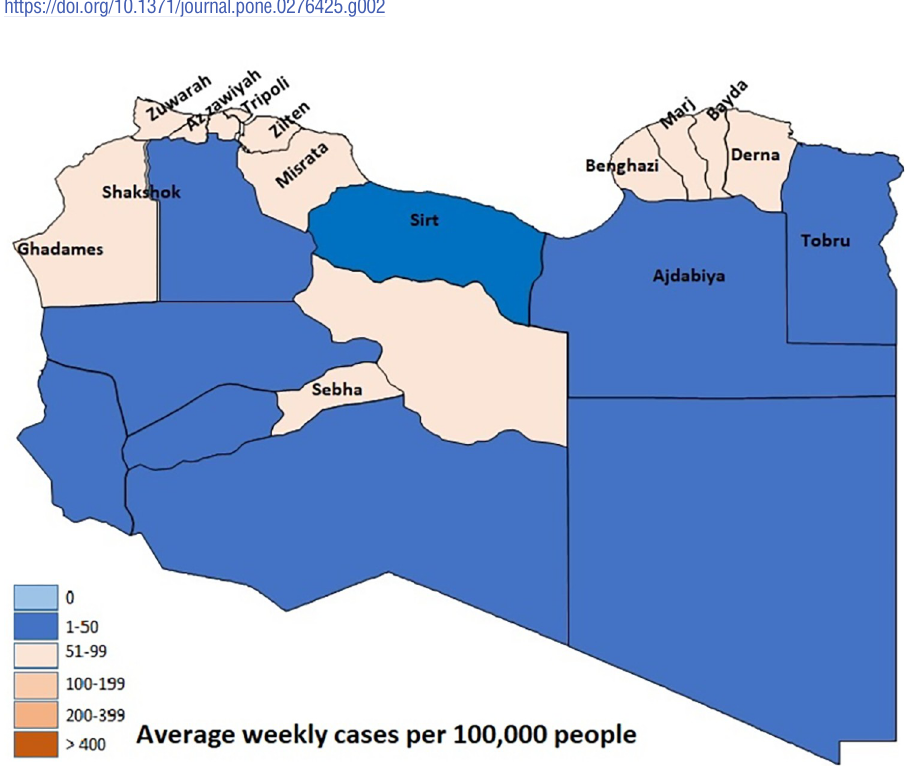
Fig 3. The geographic distribution of SARS-COV-2 infection in Libya before and after vaccine. Average weekly cases per 100,000 people. SARS-COV-2 infection in Libya after vaccine. Created by Microsoft, open streetMap.